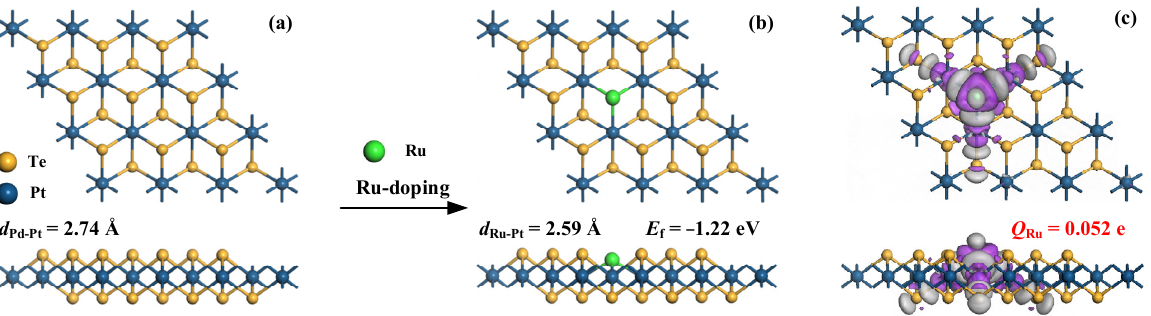
Figure 2. Ru-doping property on the PtTe 2 surface: ( a ) morphology of intrinsic PtTe 2 monolayer, ( b , c ) morphology and CDD of Ru-PtTe 2 . In CDD, the grey and purple areas are electron accumulation and electron depletion, and the isosurface is 0.01 eV/A 3 .